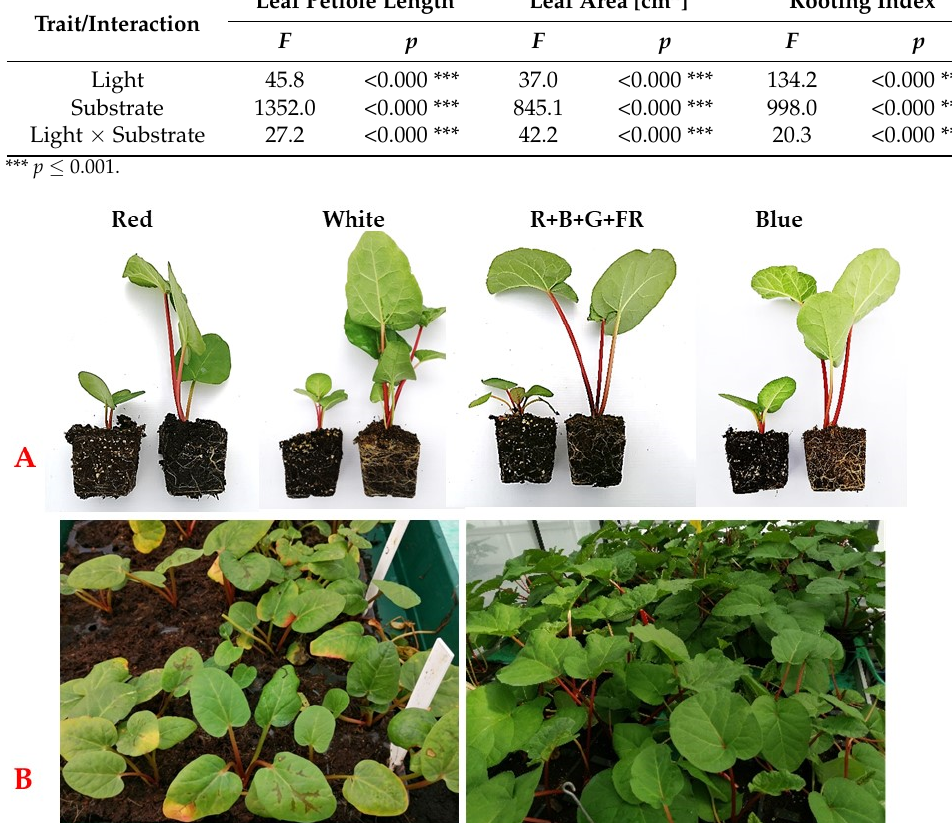
Figure 3. The morphology of the rhubarb ‘Raspberry’ plantlets: ( A ) After 6 weeks of growing under lighting by different LED treatments (R—red, W—white, B—blue, R+B+G+FR—far red) in various growth media (on the left—in the neutralised sphagnum peat (GM2); on the right—Floragard substrate (GM1); ( B ) after 10 weeks of growing under W-LEDs and in GM2 (on the left) and GM1 (on the right).